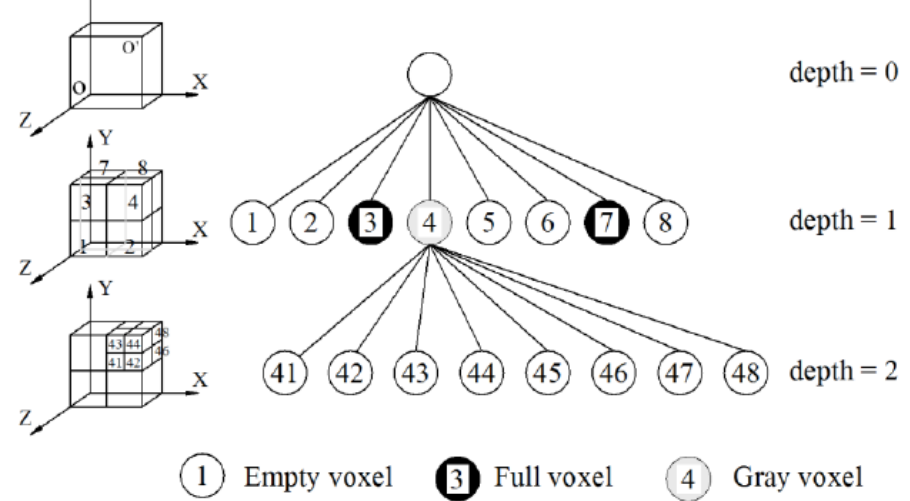
Figure 3. Illustration of the structure and construction of a sparse voxel octree (reprinted from Truong-Hong and Laefer [22] with permission from Elsevier).